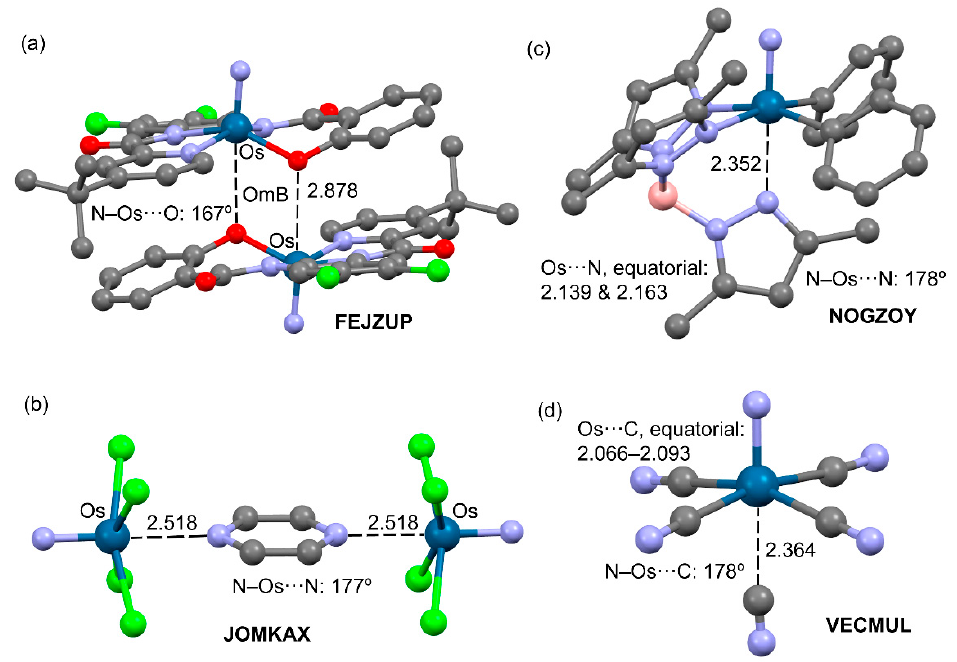
Figure 1. ( a ) Partial view of the X-ray structure with refcode FEJZUP. Distances are in Å. H atoms are omitted for clarity; ( b ) partial view of the X-ray structure with refcode JOMKAX. Distances are in Å. H atoms and counter-ions are omitted for clarity; ( c ) partial view of the X-ray structure with refcode NOGZOY. Distances are in Å. H atoms are omitted for clarity; ( d ) partial view of the X-ray structure with refcode VECMUL. Distances are in Å. H atoms and counter-ions are omitted for clarity.